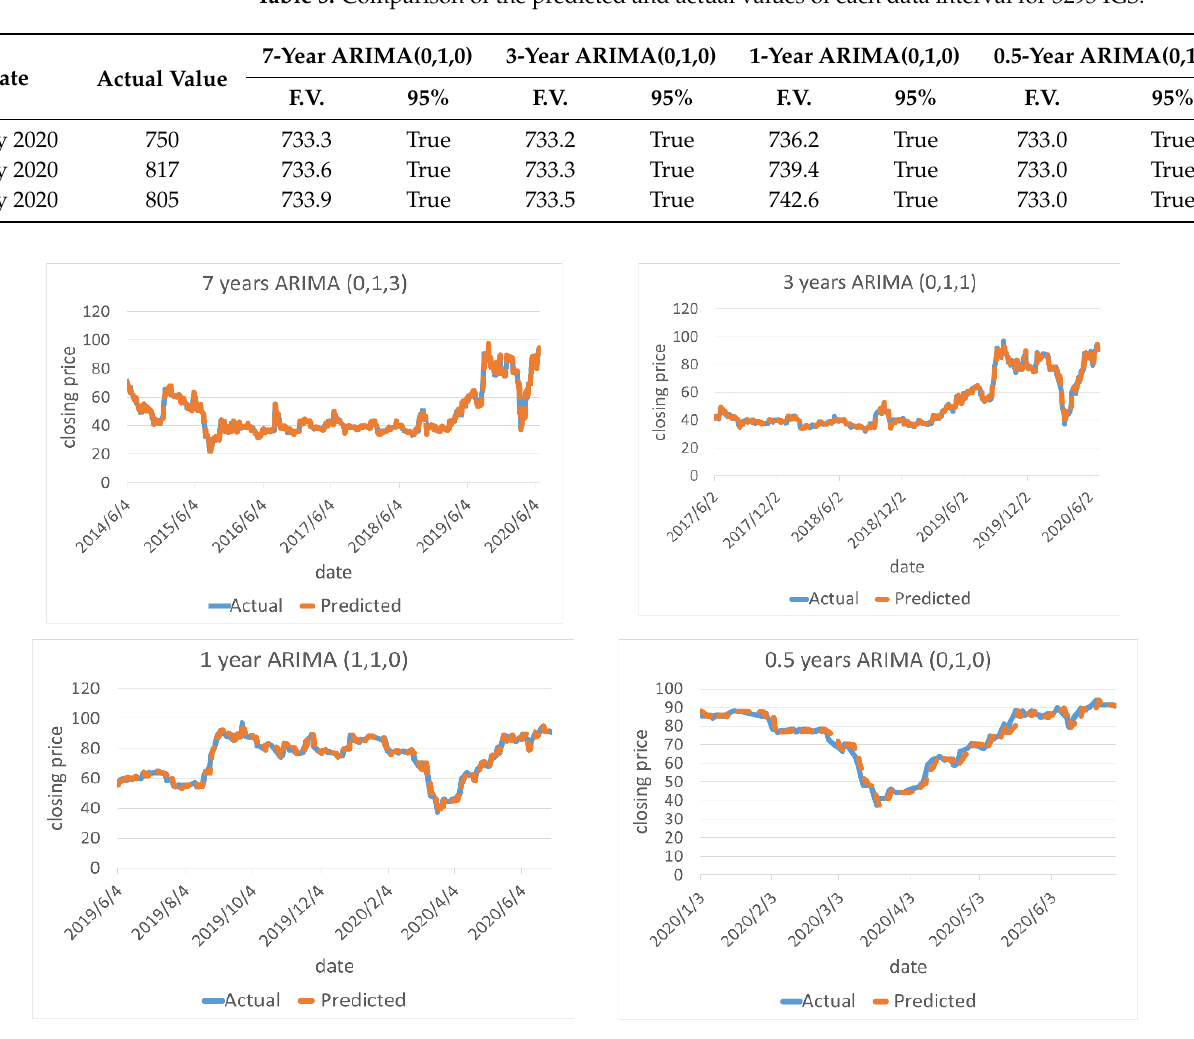
Figure 2. Prediction diagram of the optimal ARIMA models for 7, 3, 1, and 0.5 years for 3083 ChineseGamer.